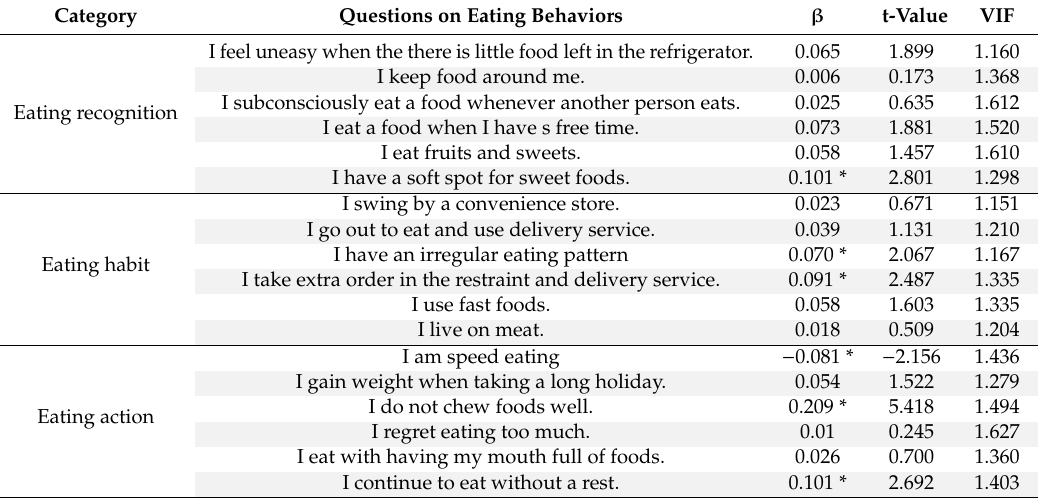
Table 3. Results of multiple regression analysis after age-adjusted. (* p < 0.05).